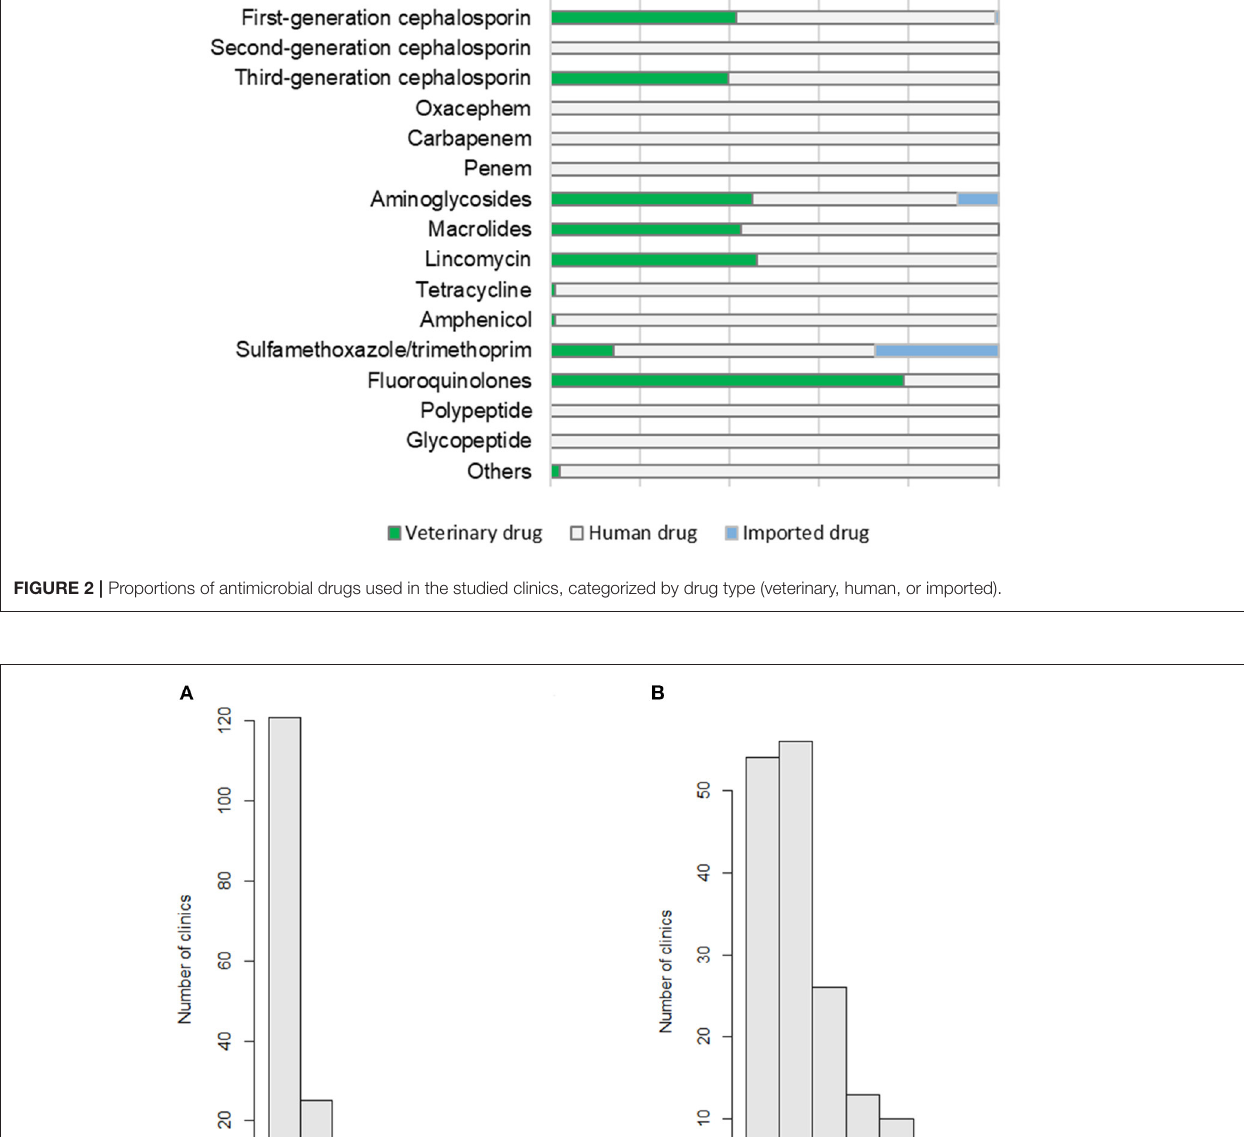
where the director was 60 years old was particularly high when the years in operation was short ( Figure 6A ), reflecting an outlier ( Figure 5A